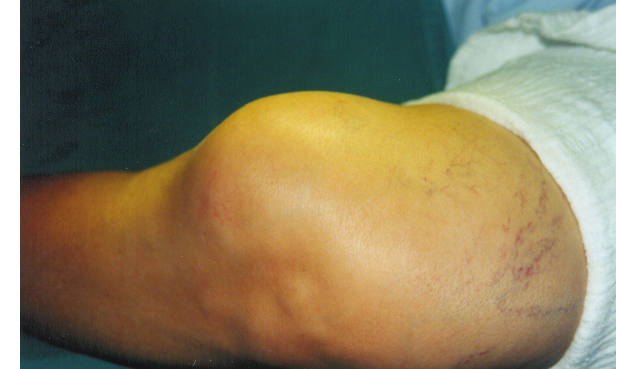
Figure 1 - External aspect of the cyst